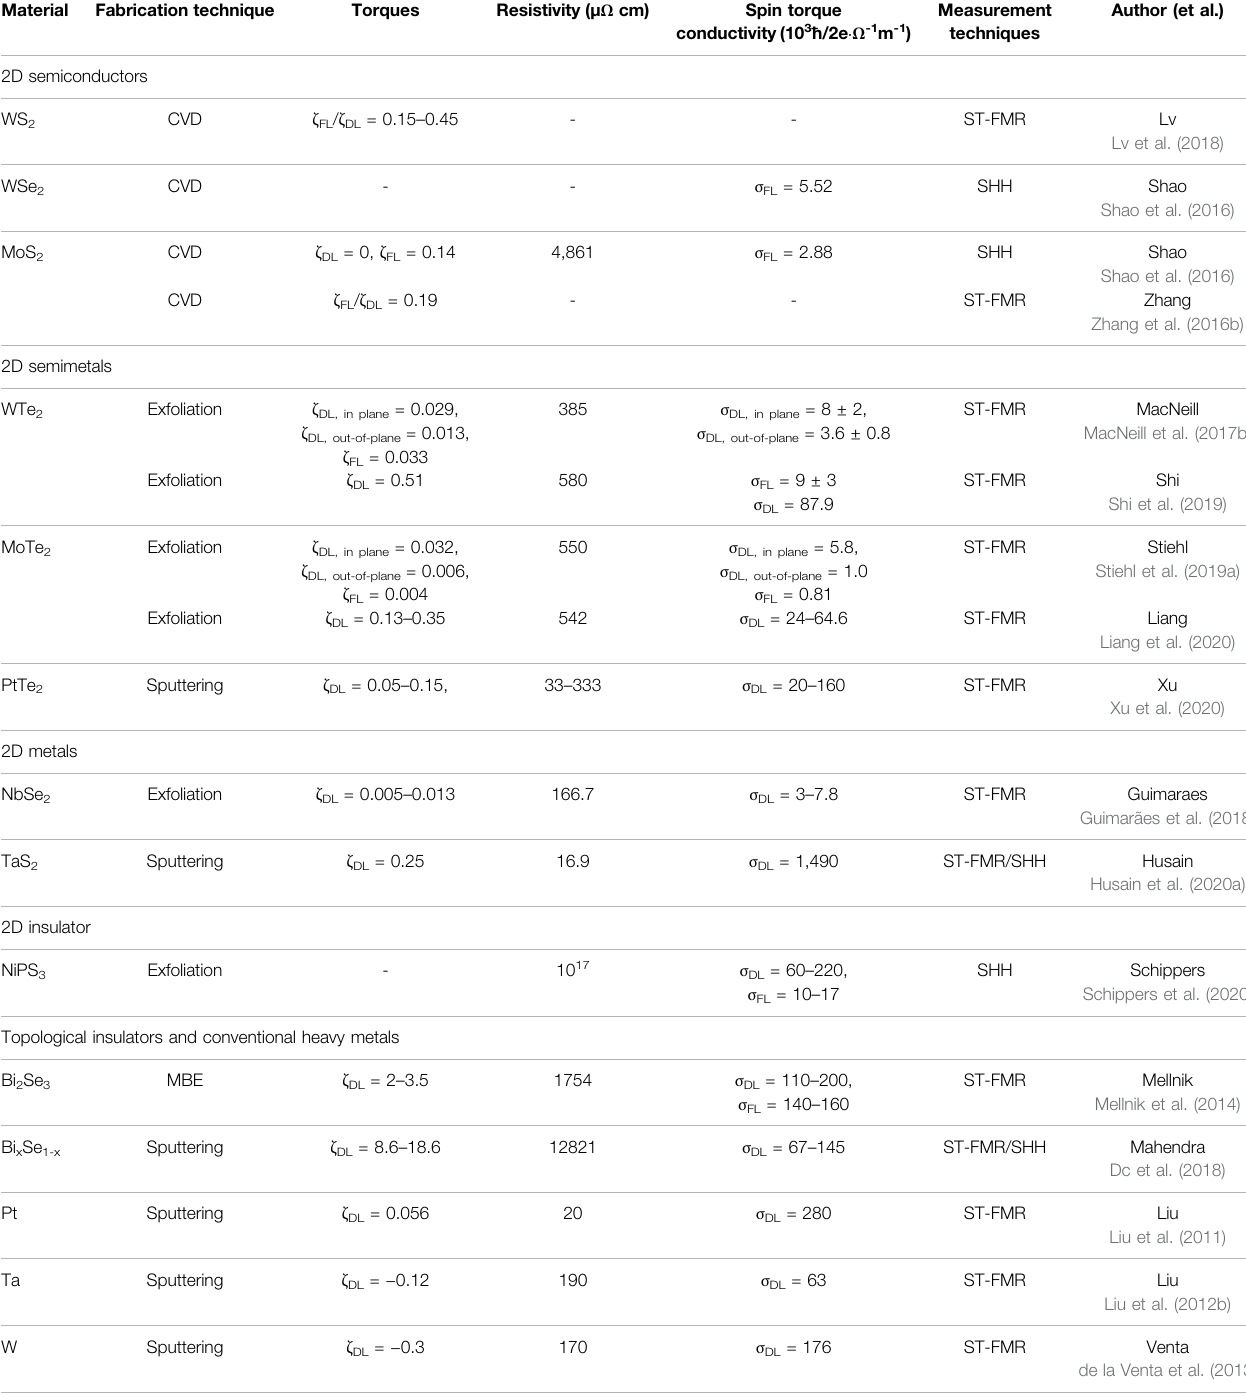
TABLE 1 | Main results for 2D vdW/FM SOT